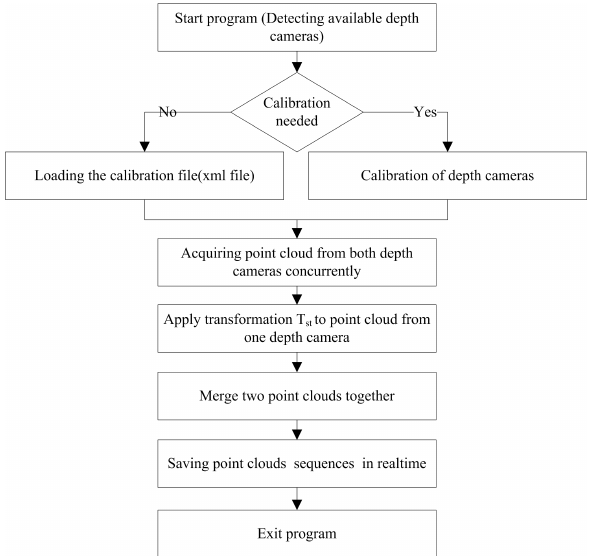
Figure 2. An example of calibration session by using our calibration tool.